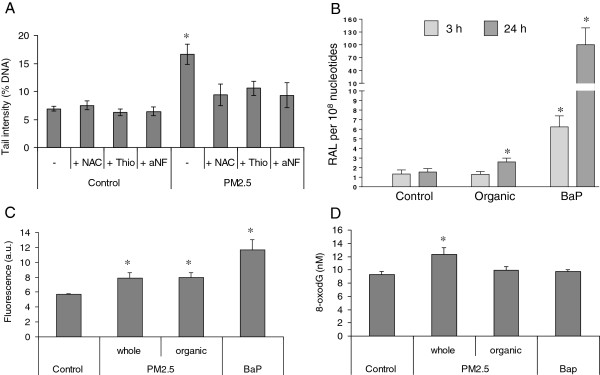
DNA damage. (A) SCGE assay. BEAS-2B cells were exposed to 7.5 μg/cm2 of winter PM2.5 for 3 h. NAC, Thio and α-NF were used to determine the role of ROS and CYP enzymes, respectively. DNA damage is expressed as % of tail intensity (% DNA in tail). (B) DNA adduct formation in BEAS-2B cells exposed to 7.5 μg/cm2 of PM organic extract and 15 μM BaP for 3 and 24 h measured by 32P-postlabelling. Total bulky adducts (RAL, relative adduct labelling) were measured across the DRZ, diagonal radioactive zone of the TLC autoradiogram. (C) γH2AX expression measured by flow cytometry. BEAS-2B cells were exposed to 7.5 μg/cm2 of winter PM2.5 and organic extract for 3 h, and 15 μM of BaP for 24 h. The results are reported as fluorescence arbitrary units. (D) Formation of 8-oxodG. BEAS-2B cells were exposed to 7.5 μg/cm2 of winter PM2.5 and organic extract, and to 15 μM of BaP for 3 h. The results are reported as 8-oxodG in nM. All data are expressed as mean ± SEM of 3 independent experiments. * Statistically significant difference from untreated cells (control), P < 0.05.